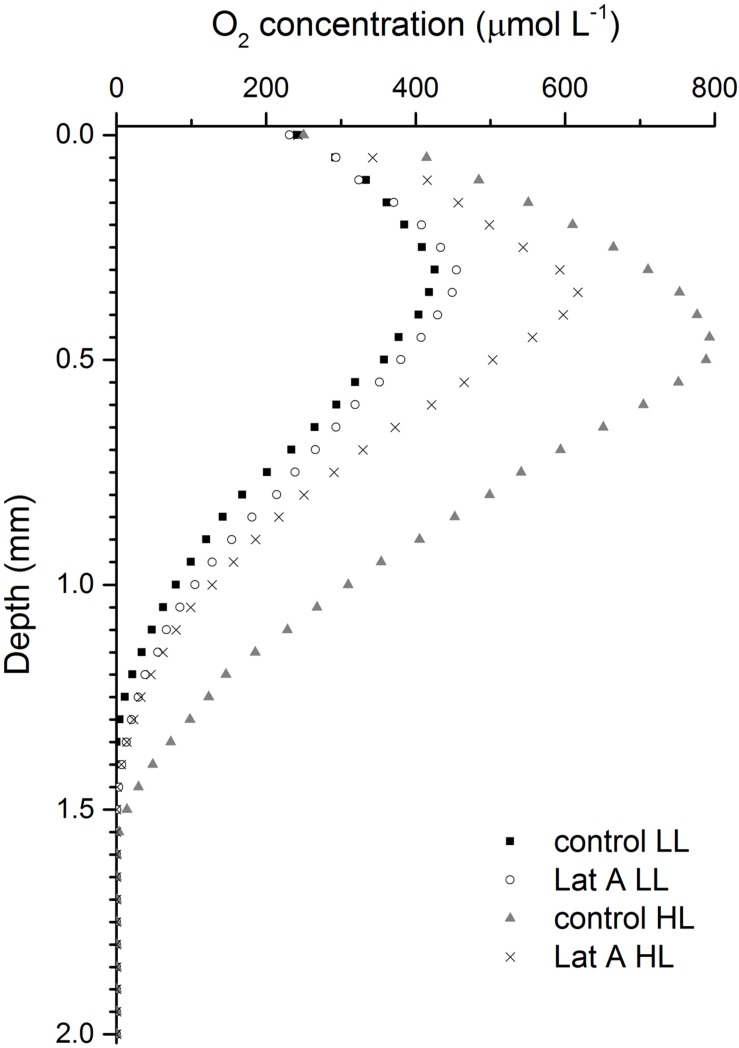
Depth profiles of O2 concentrations for untreated (control) and latrunculin A (Lat A) treated intertidal sediments under low light (LL, 150 μmol photons m-2 s-1) and after 30 min exposure to high light (HL, 2000 μmol photons m-2 s-1).